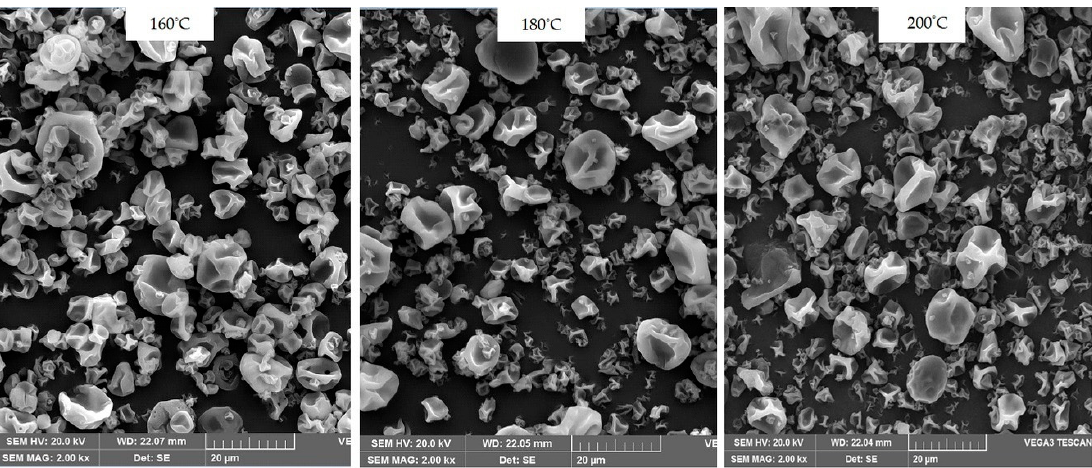
Figure 2. SEM images of FOCE spray-dried powders.